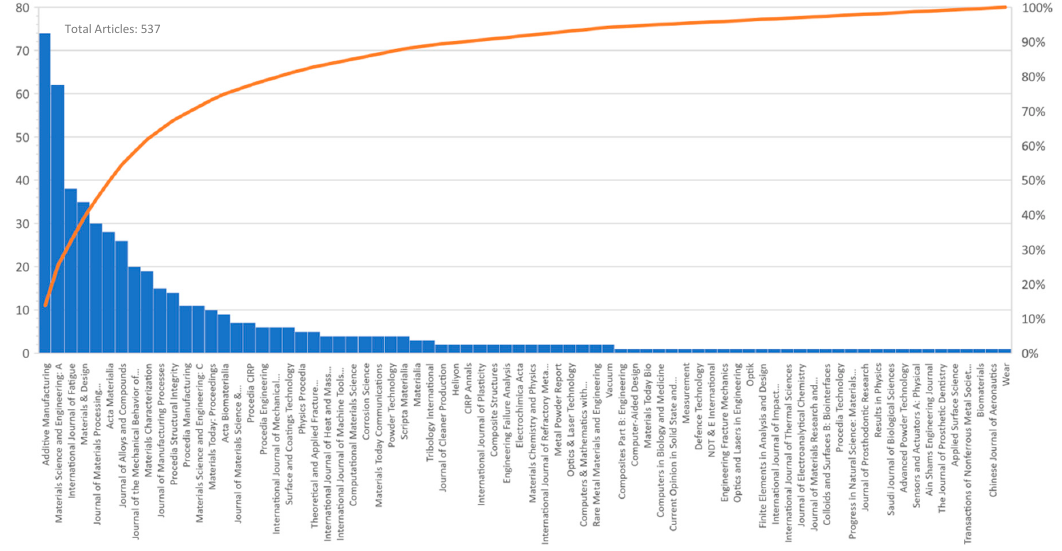
Figure 4. Pareto’s chart of the research “Additive Manufacturing + Ti–6Al–4V” on ScienceDirect.